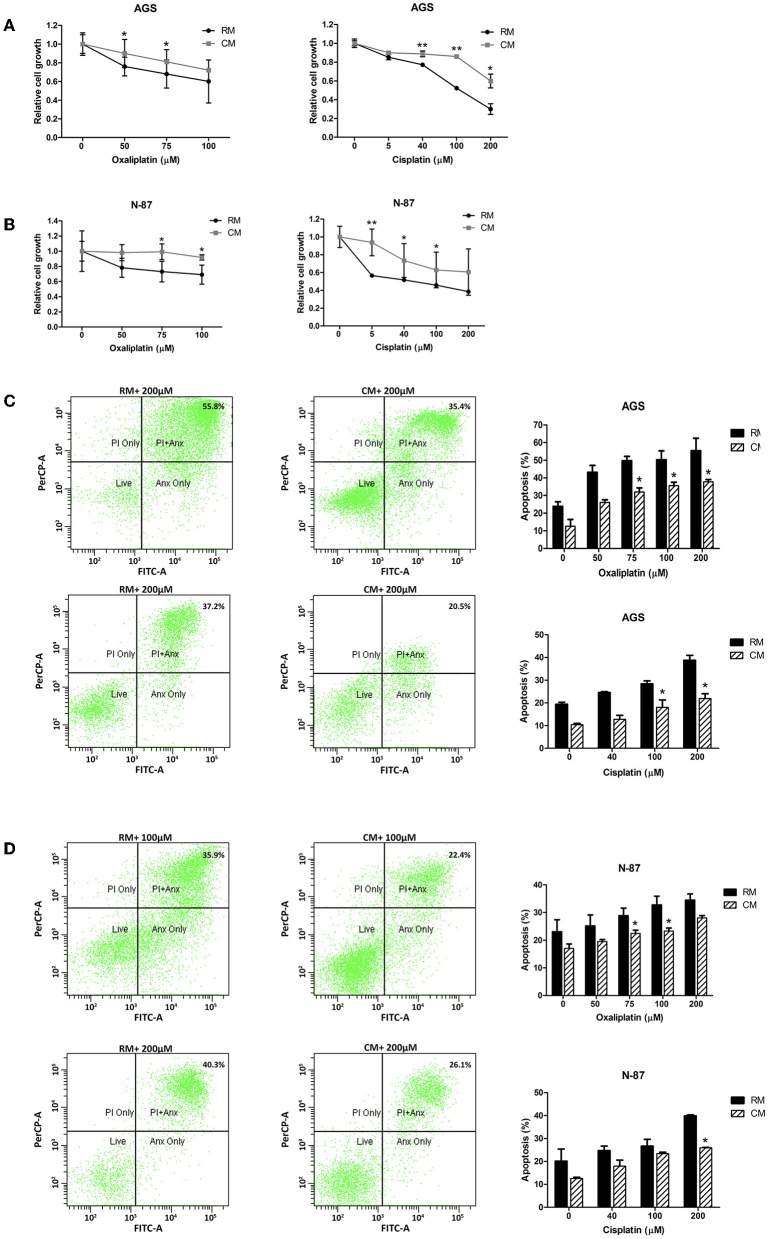
Omental tissue CM augments gastric cancer cells resistance to chemotherapy. (A,B) Increased survival of oxaliplatin and cisplatin -treated AGS (A) and N-87 (B) gastric cancer cells following co-culture with omental tissue CM (P < 0.05), n = 4; (C,D) FACS analysis using Annexin-V/PI demonstrating a significant reduction in oxaliplatin and cisplatin -induced apoptosis of AGS (C) and N-87 (D) cells co-cultured with omental tissue CM (P < 0.05), n = 5. *P < 0.05; **P < 0.01.